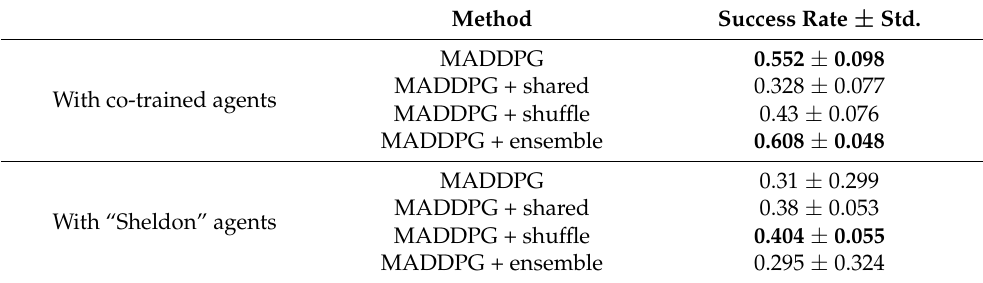
Table A1. Numerical results shown in Figure 5. Success rate refers to the fraction of episodes where agents covered all three landmarks. The best result for each block (up to significance shown in Table A2) is shown in bold. Notice that the results consist of 5 values in the case of co-trained agents and 45 values in the case of “Sheldon” agents. Every single value by itself is the fraction of episodes where all agents covered all landmarks out of 4000 evaluation episodes.